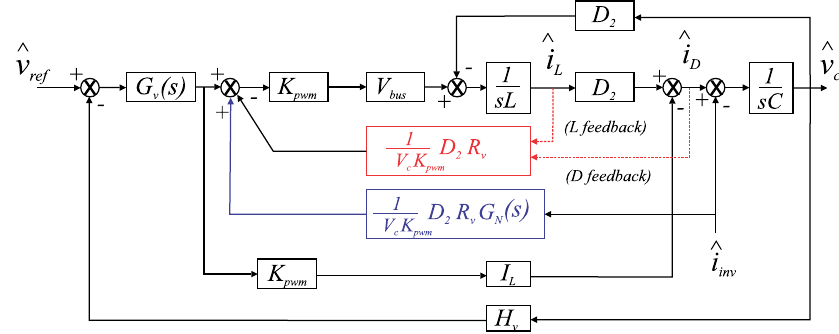
Figure 28. NF-LCFFS with